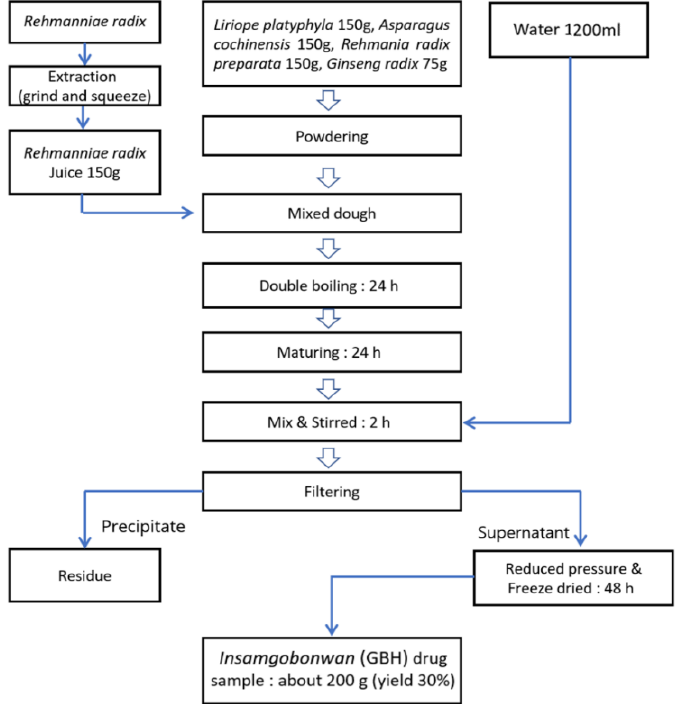
Figure 1. Diagram of the GBH preparation from the raw materials to final freeze-dried product.